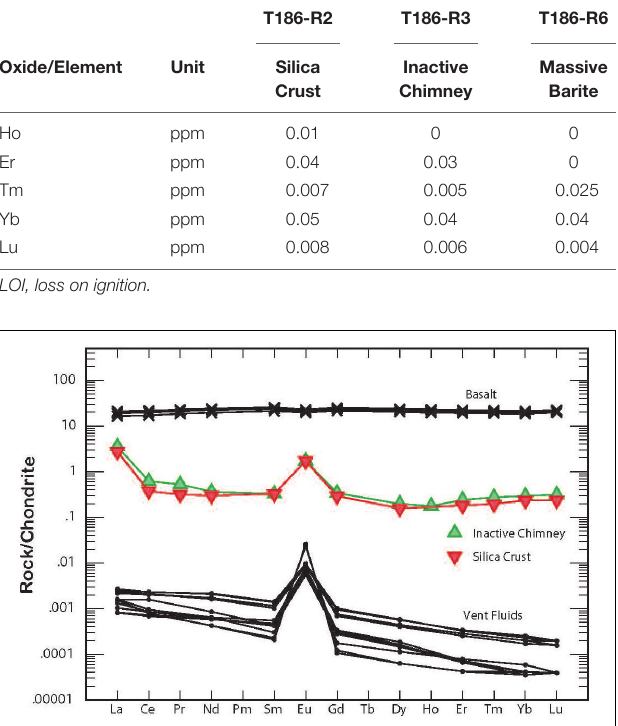
FIGURE 10 | Chondrite-normalized rare earth patterns for Sea Cliff hydrothermal deposits (green and red symbols, from Table 1 ), hydrothermal fluids (black dots, from Fowler et al., 2019) and a range of patterns for North Gorda basalt samples (Xs, from Davis et al., 2008). The deposit samples mirror the fluid compositions in having positive Eu